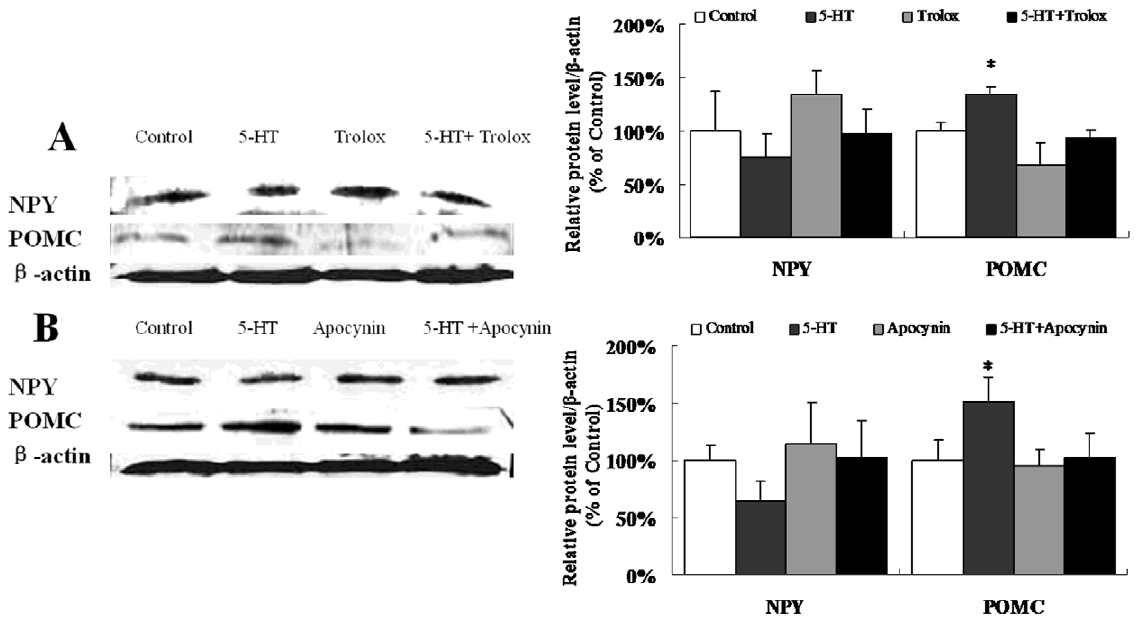
Figure 6. 5-HT-induced NPY and POMC protein expression. Western blot analysis of NPY and POMC in the hypothalamus. (A) ICV co-injection with 5-HT and Trolox. n=3 per group. (B) ICV co-injection with 5-HT and Apocynin. n=3–4 per group. Data are expressed as the means 6 SEM. *, 0.01 , p , 0.05, vs. the control.